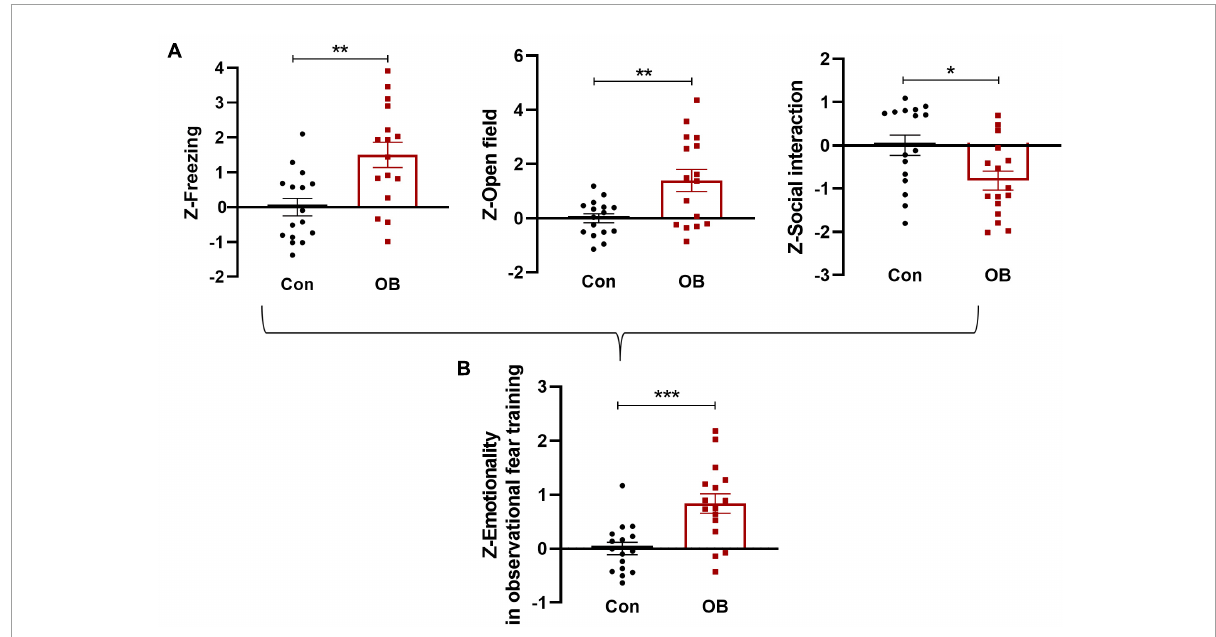
FIGURE5 Integrated emotionality Z -scores in mice exposed to observation fear training on day 1. (A) FZ, OF, and SI test Z -values were calculated by averaging individual Z -scores as described above and (B) averaged to obtain an integrated emotionality Z -score. Data are expressed as mean ± SEM ( n = 16) and compared by unpaired t -test. * p < 0.05, ** p < 0.01, *** p <